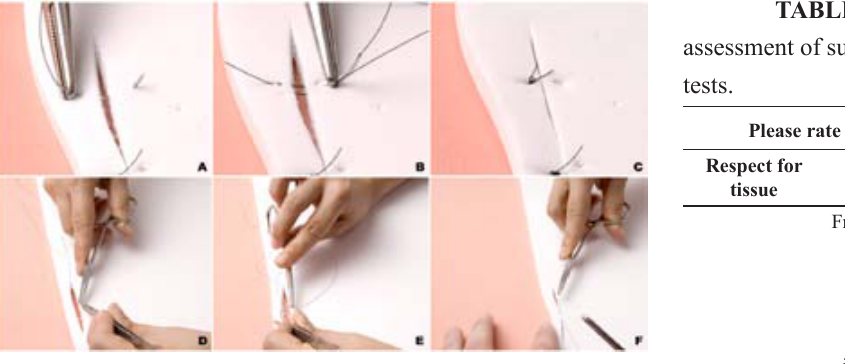
FIGURE 1 – Synthetic ethylene-vinyl acetate bench model simulating a ( A-C ) vertical mattress suture and a ( D-F ) subdermal interrupted suture.